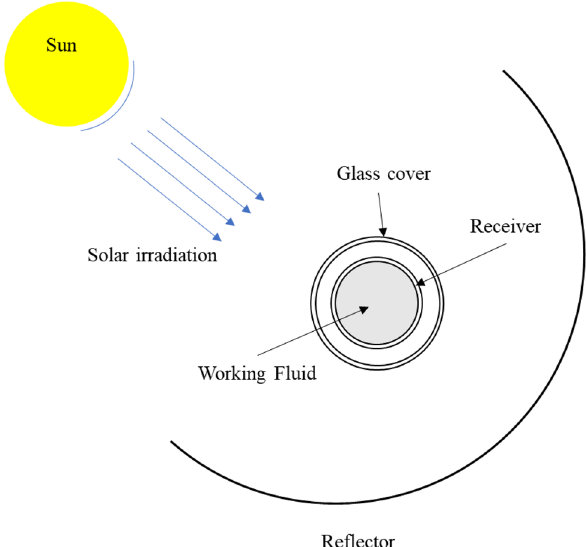
Figure 2. PTC schematic